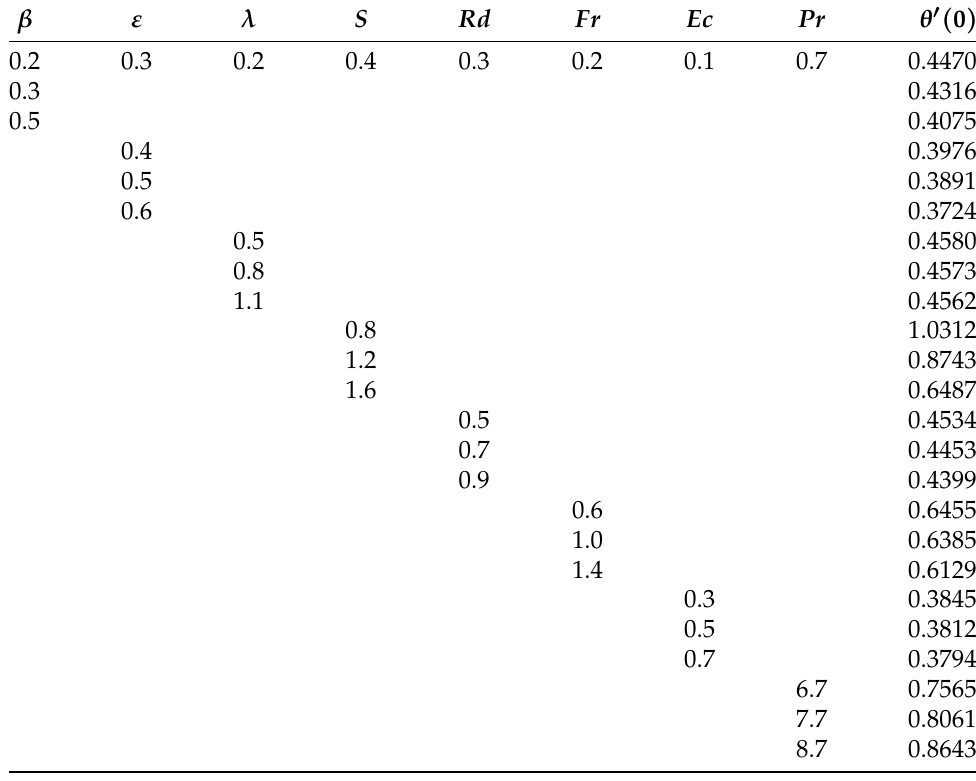
Table 3. Influence of β , ε , λ , S , Rd , Fr , Ec , and Pr on θ (cid:48) ( 0 ) .